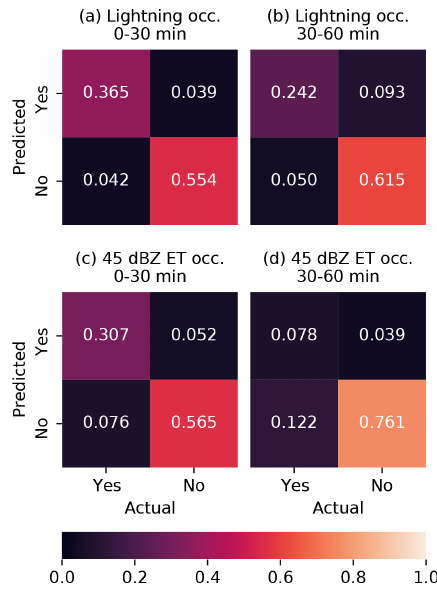
Figure 5. Confusion matrices for (a, b) the LIGHTNING-OCC pre- diction task and (c, d) the ECHO45-OCC